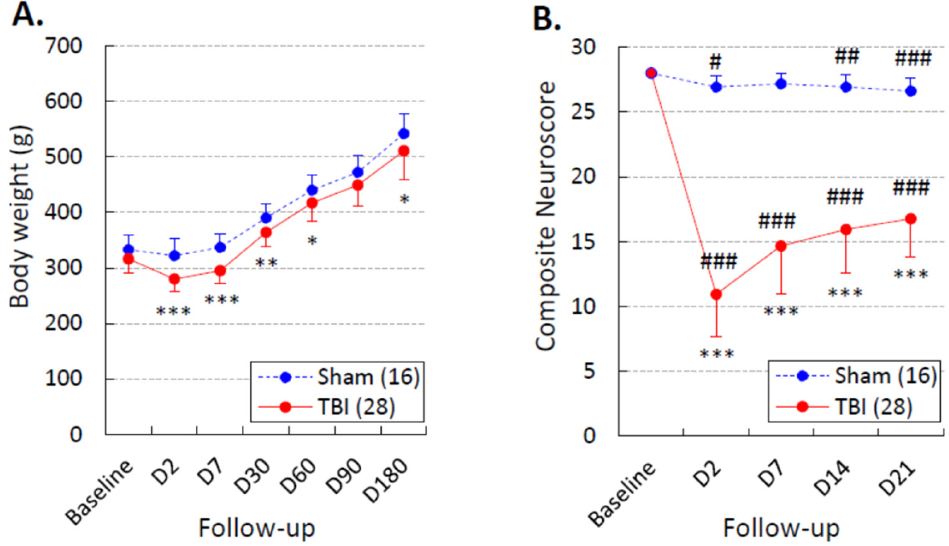
Figure 6. Body weight and performance in the composite neuroscore test: ( A ) Body weight was slightly lower in the traumatic brain injury (TBI) group (red line) than in the sham group (dashed blue line) over the 180-day monitoring period (repeated-measures ANOVA: time effect p < 0.001, group effect p < 0.01, time x group effect p > 0.05). ( B ) The composite neuroscore test was performed before the first pentylenetetrazol (PTZ) test session. Although rats with TBI showed somatomotor recovery between D2 and D7 ( p < 0.001, Wilcoxon), they did not reach the performance level of sham-operated experimental controls during the 3-week post-injury period (repeated-measures ANOVA: time effect p < 0.001, group effect p < 0.001, time x group effect p < 0.001). Data are shown as the mean ± standard deviation of the mean. Statistical significance: *, p < 0.05; **, p < 0.01; ***, p < 0.001 (Mann–Whitney U test compared with the sham group); #, p < 0.05; ##, p < 0.01; ###, p < 0.001 (Wilcoxon test compared with the baseline).